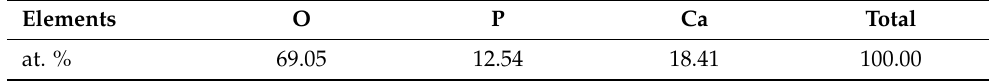
Table 2. Elemental composition of the HAp powder derived from the EDS measurements.